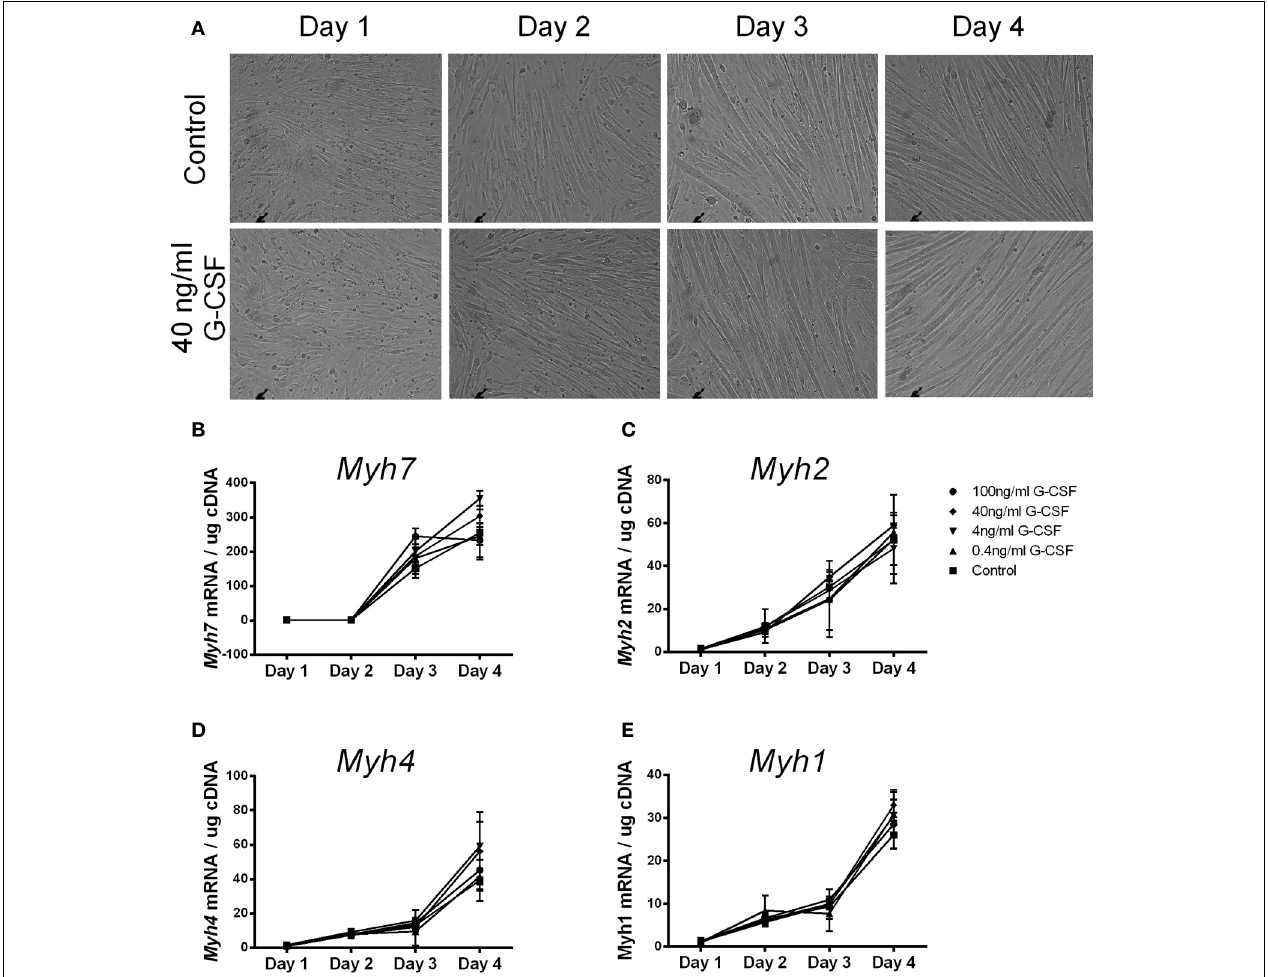
FIGURE 6 | The effects of G-CSF treatment on expression of Myh genes during C2C12 cell differentiation. (A) Light microscope images of C2C12 cells at 24h intervals during differentiation under normal conditions and in the presence of 40ng/ml G-CSF. (B) Myh7 (C)